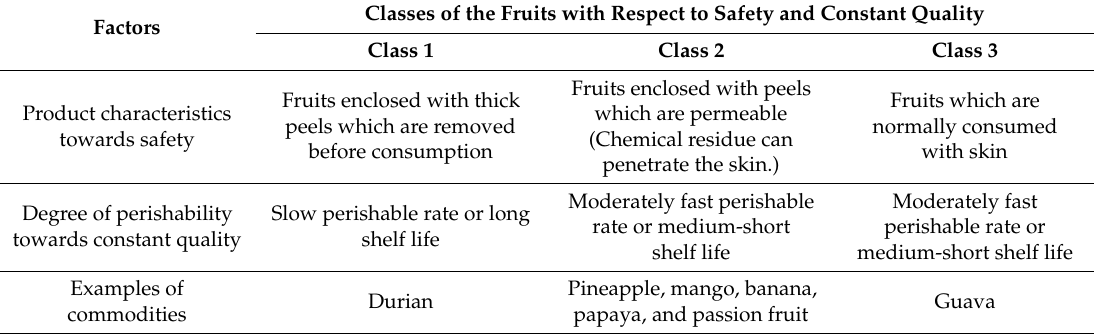
Table 3. Axis 2: degree of exposure to safety and constant quality of tropical fruits in three classes.